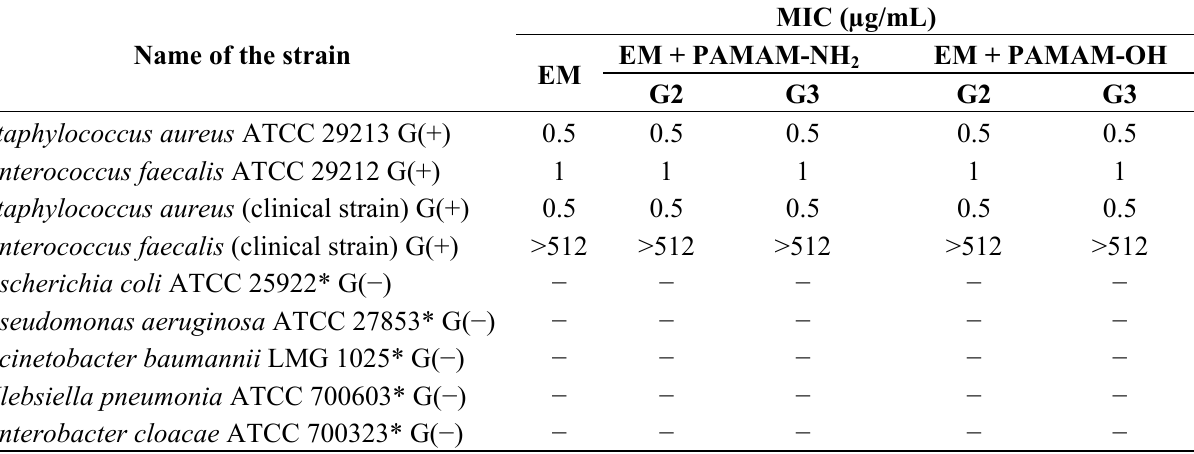
Table 1. Minimum Inhibitory Concentration-MIC (in µg/mL) of erythromycin (EM) in the presence of PAMAM-NH and PAMAM-OH dendrimers generation 2 (G2) and 2 generation 3